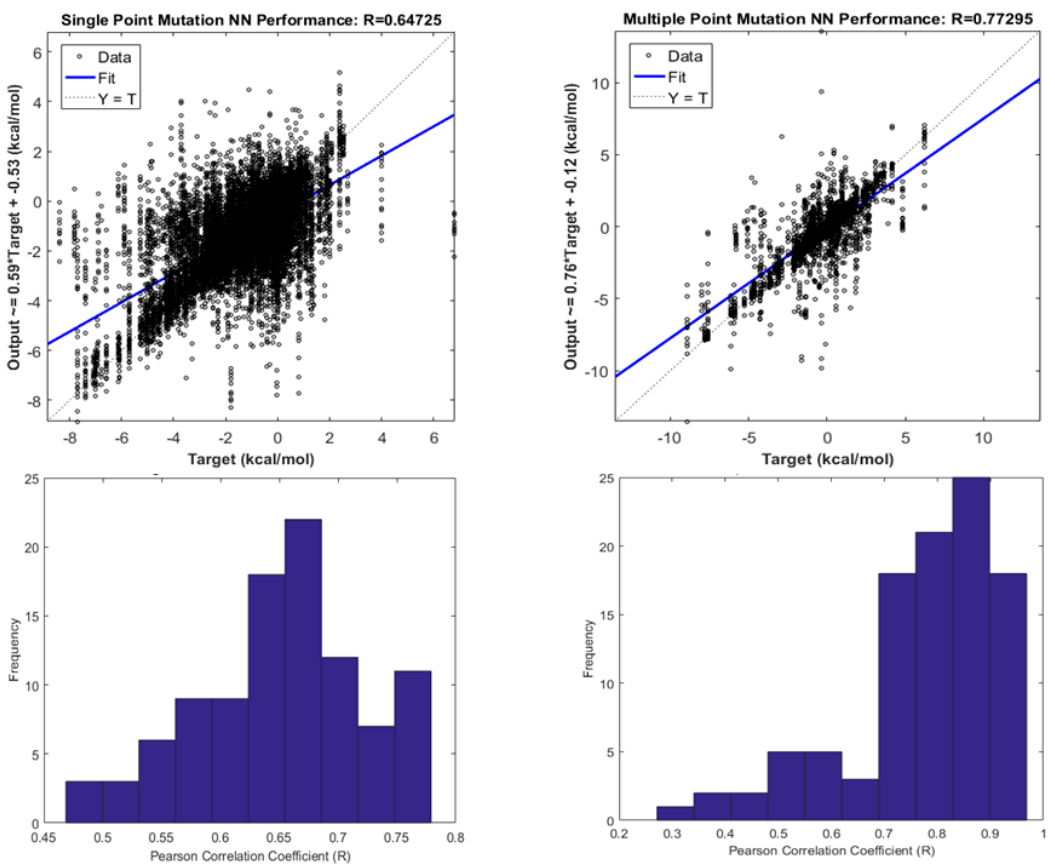
Figure 9. Average Neural Network Performance over randomly selected blind validation subsets and the corresponding Pearson Correlation Coefficient for frequency histograms for both Single Point and Multiple Point Mutations.